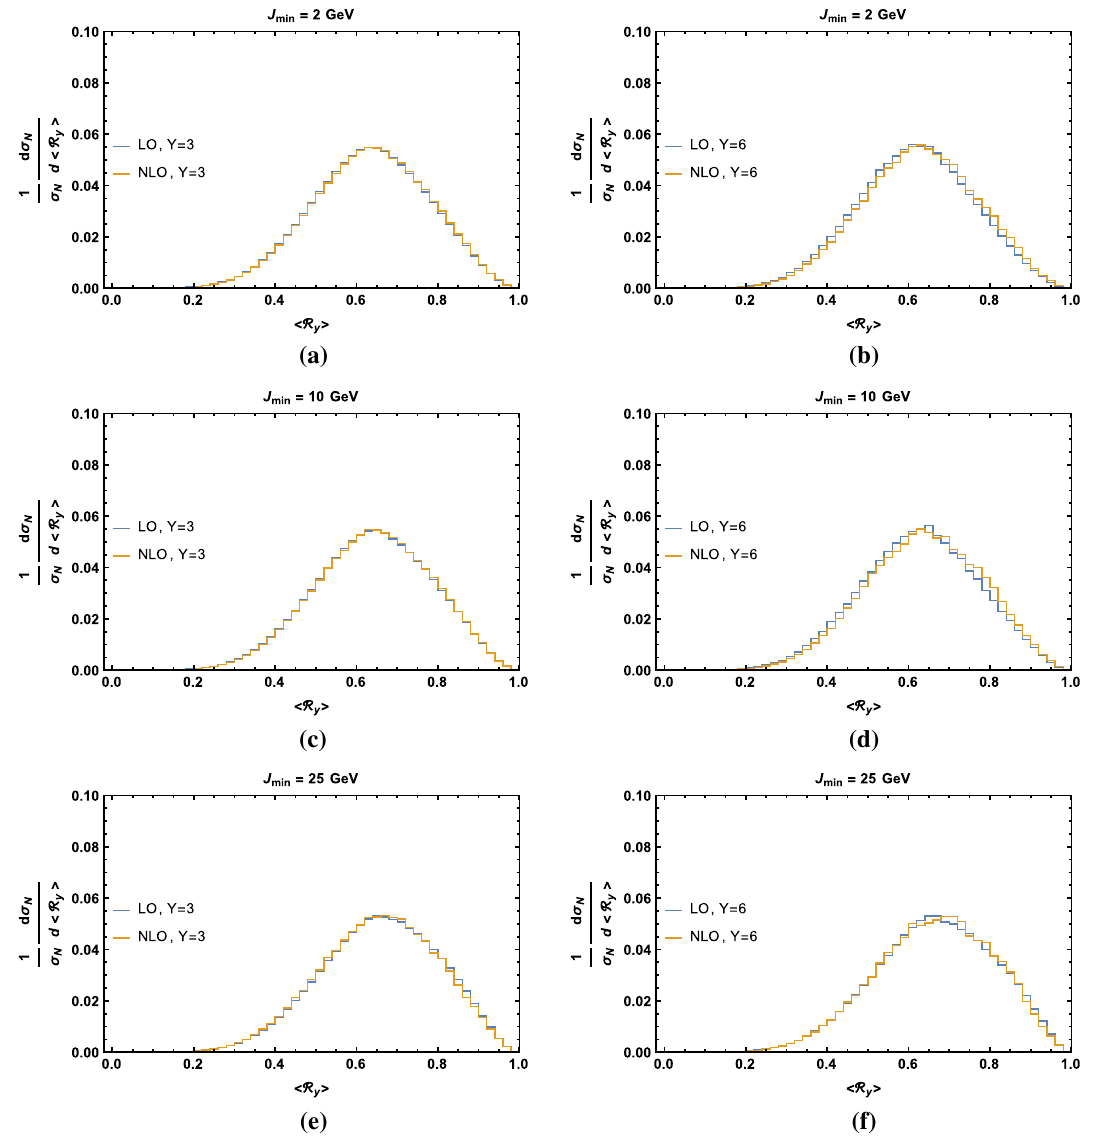
Fig. 9 Comparison of LO and NLO+DLs normalized (cid:10) R y (cid:11) distributions for multiplicity N = 4, rapidity differences Y = 3 (left) and Y = 6 (right) and J min = 2 (top), J min = 10 (middle), J min = 25